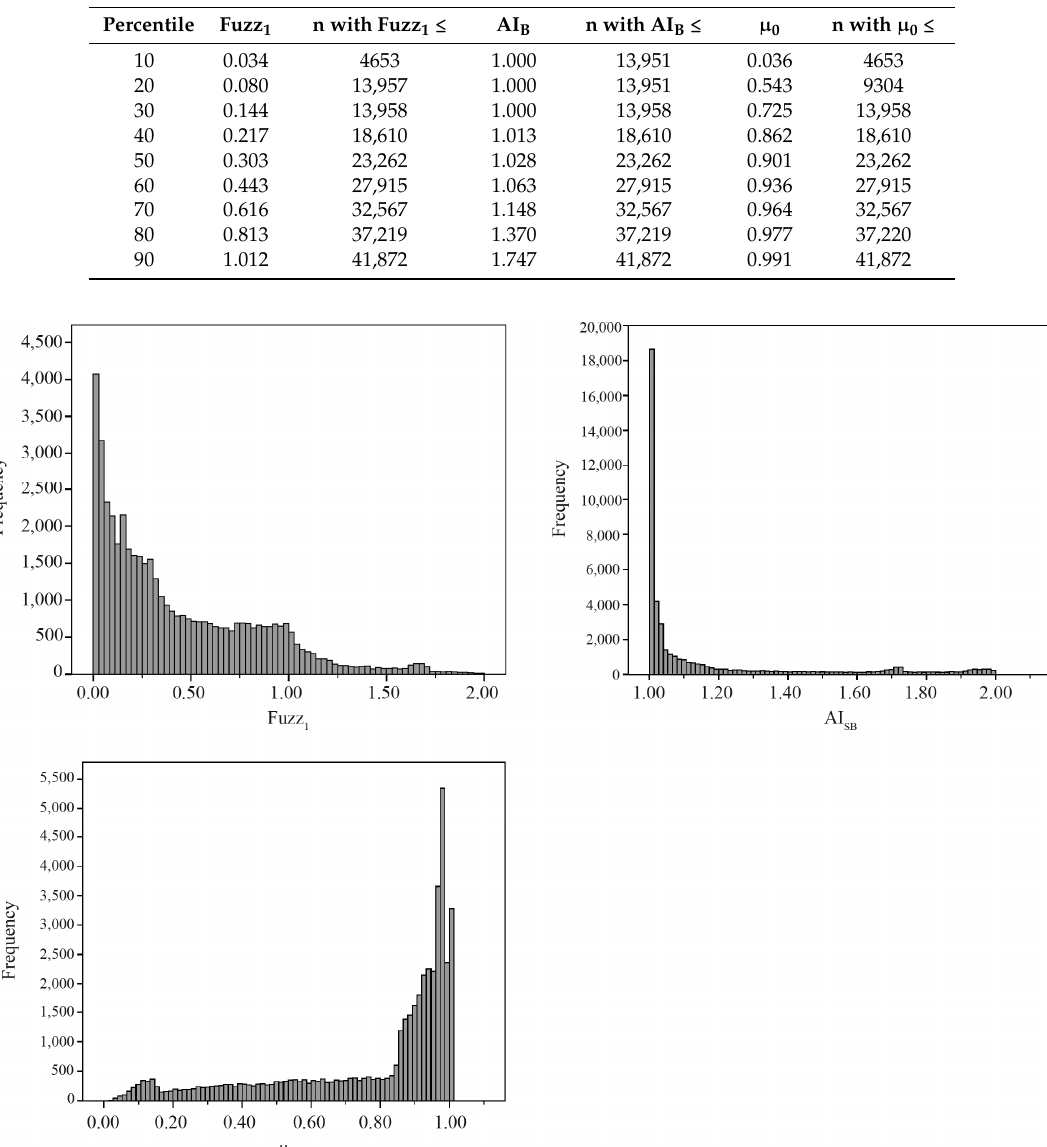
µ 1 , AI SB and 0 of fuzzy classified objects of the WV-2 scene of